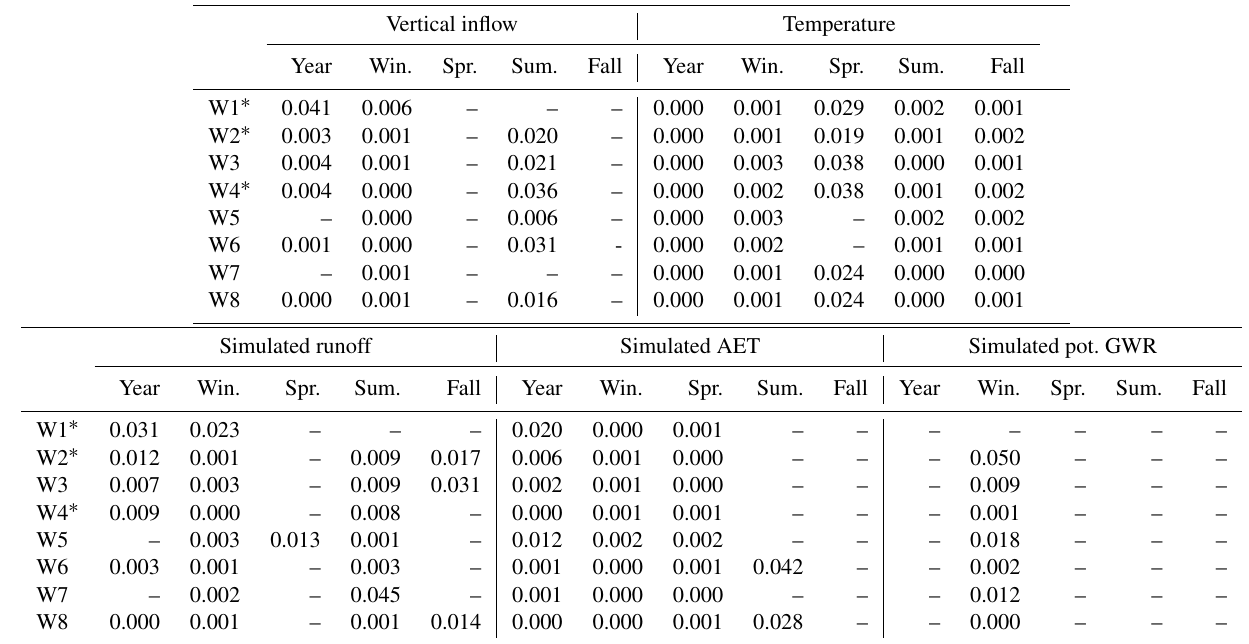
Table A2. Annual and seasonal trends for vertical inflows (rain plus estimated snowmelt), observed temperatures, simulated runoff, simulated actual evapotranspiration (AET), and simulated potential groundwater recharge (GWR) for the 1961–2017 period for the eight watersheds (Mann–Kendall test; only p values > 0.05 are presented, otherwise a “–” is used; all trends are